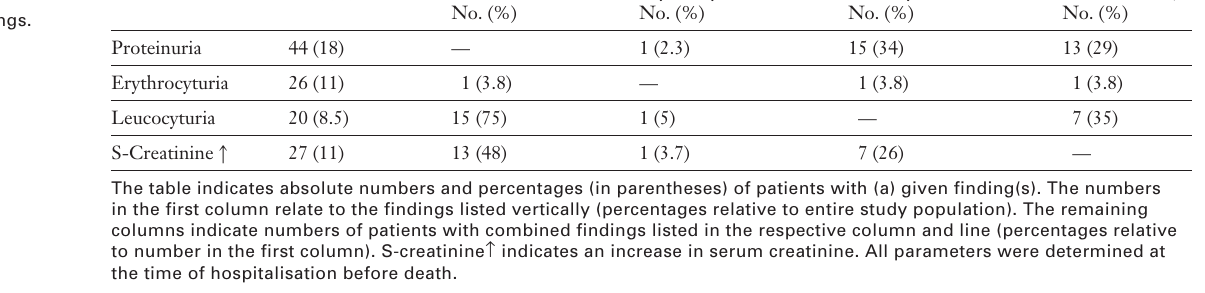
Clinical findings.